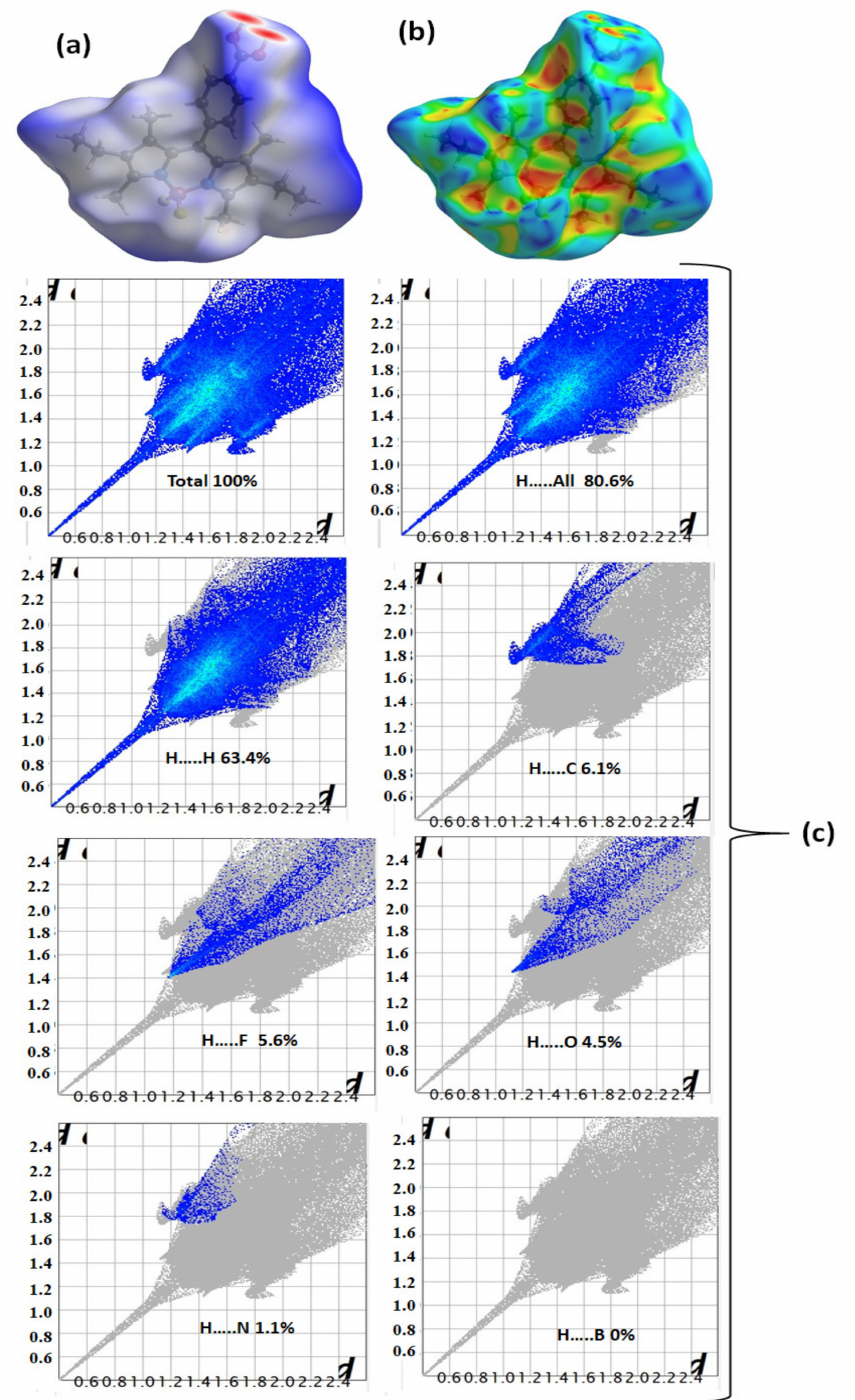
Figure 5. ( a ) d norm HSA map, ( b ) shape index, and ( c ) 2D-FP